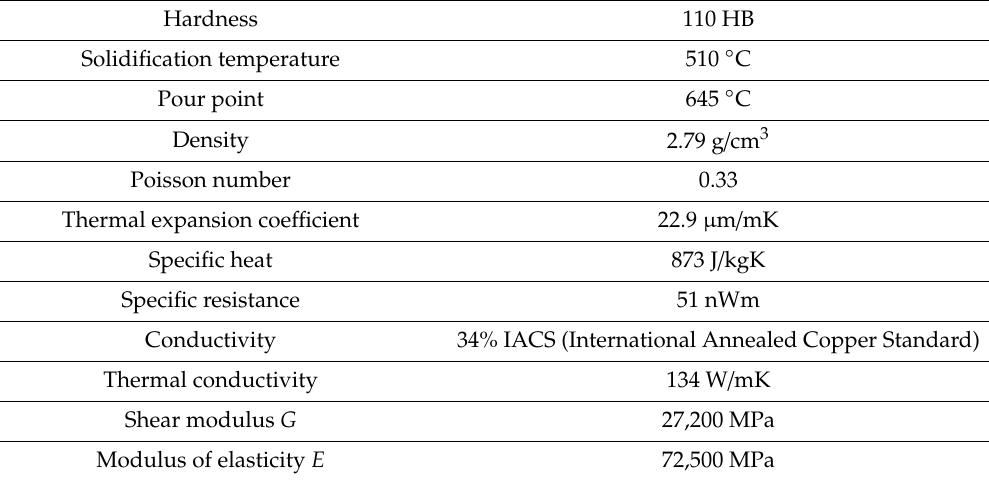
Table 2. The physical properties of aluminum